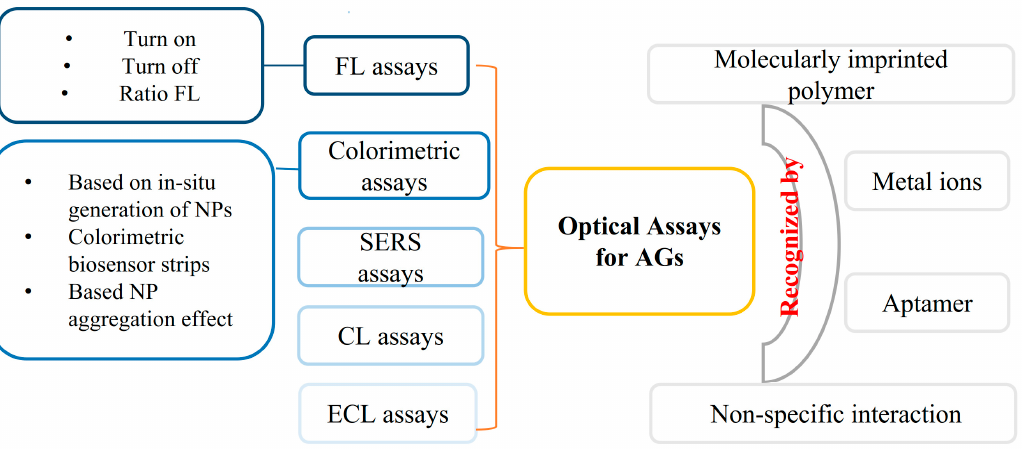
Figure 2. Illustration of optical detection methods for